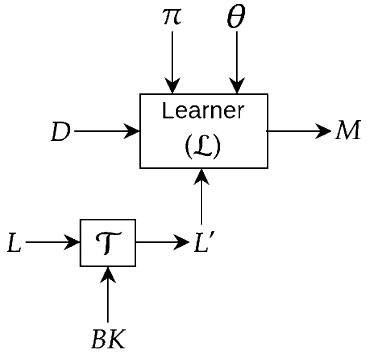
Figure 7. Introducing background knowledge into deep network by transforming the loss function L . T